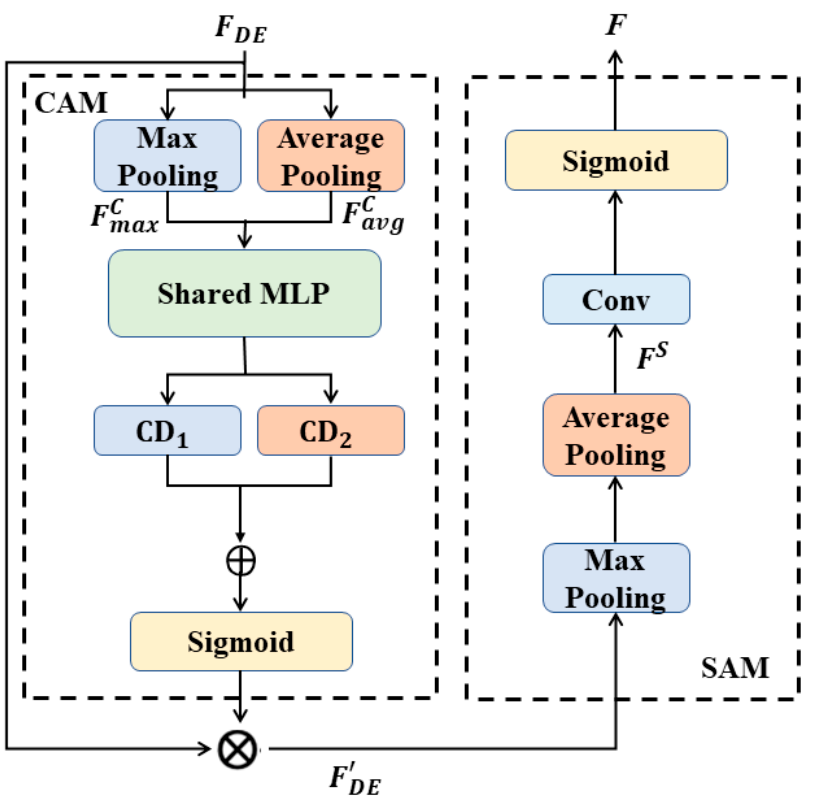
Figure 7. Feature refinement module with CAM and SAM.